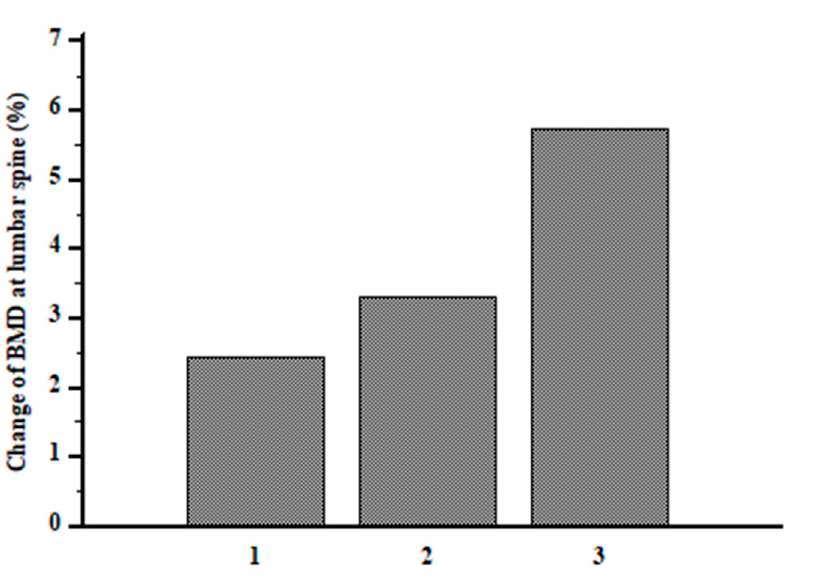
Figure 3. Change of BMD at lumbar spine after ALN discontinuation according to tertiles of serum 25(OH)D variation.